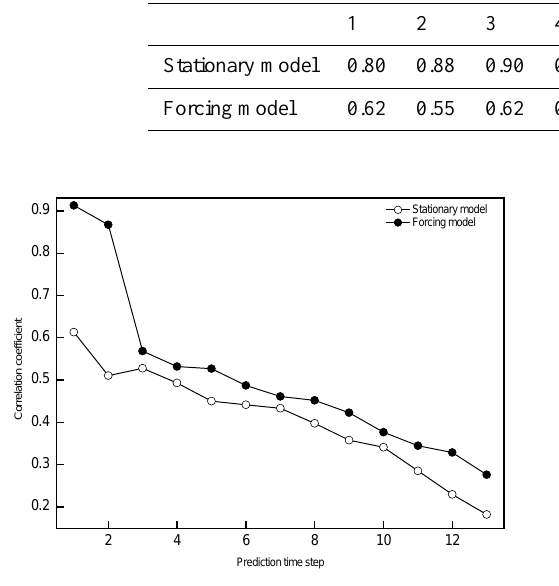
Table 1. RMSE comparison of the prediction experiments (unit: Dobson units).